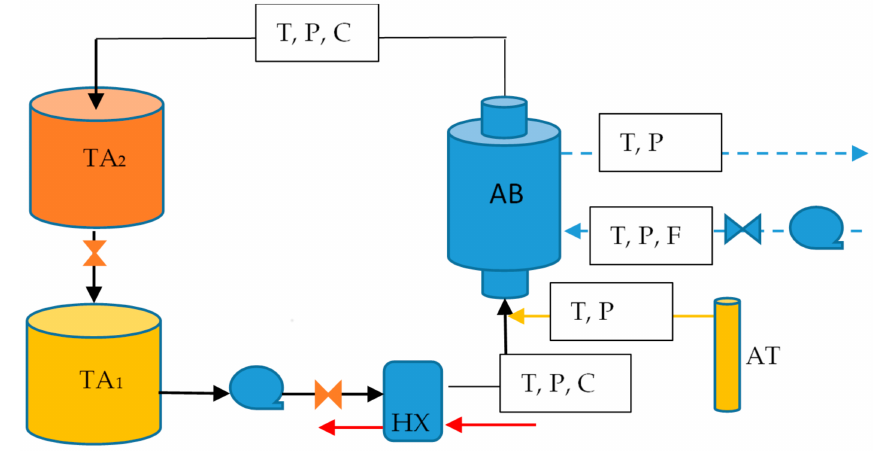
Figure 1. Schematic diagram of the experimental rig.